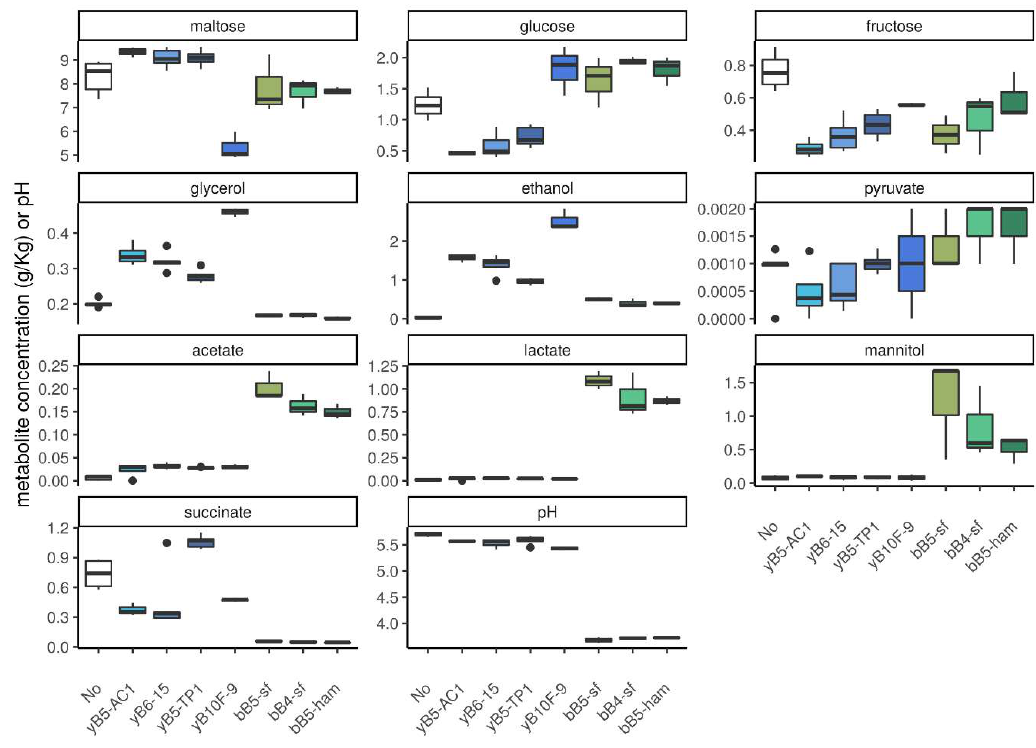
Figure 3. Metabolite concentration and pH in monocultures of yeasts and obligately heterofermentative LAB strains. Green indicates obligately heterofermentative LAB. Blue indicates yeasts, with S. cerevisiae in dashed lines and K. humilis in plain